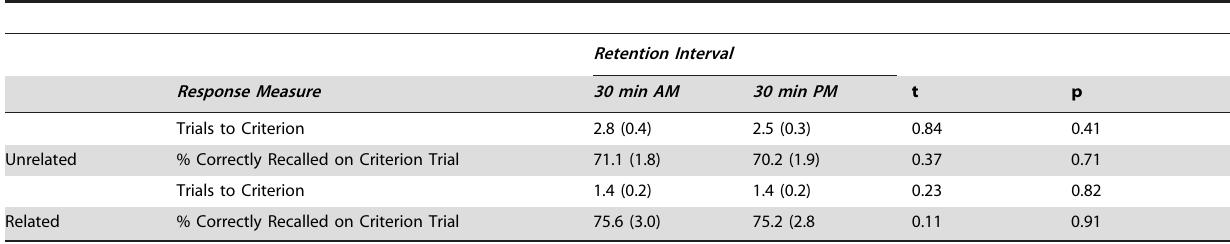
Table 1. Performance at training on unrelated and related paired-associates in the 30 minute groups (Morning,